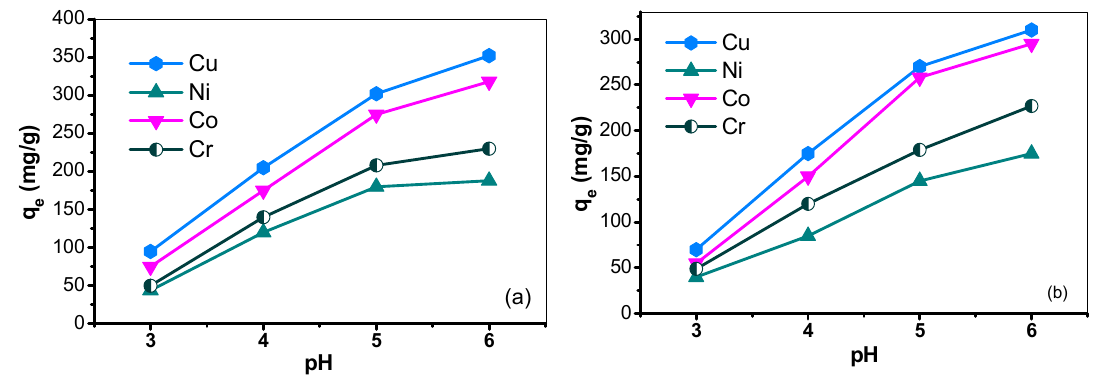
Figure 8. The effect of pH on the adsorption of heavy metal ions by the jute cellulose-based polymer ligands: ( a ) PHA ( left graph) and ( b ) PA ligand ( right graph); experimental variables: 0.5 g of ligand (PHA or PA), 15 mL of distilled water, 5 mL of sodium acetate buffer solution at pH 3–6, 5 mL of 0.2 M metals solution and stirred for 2 h.